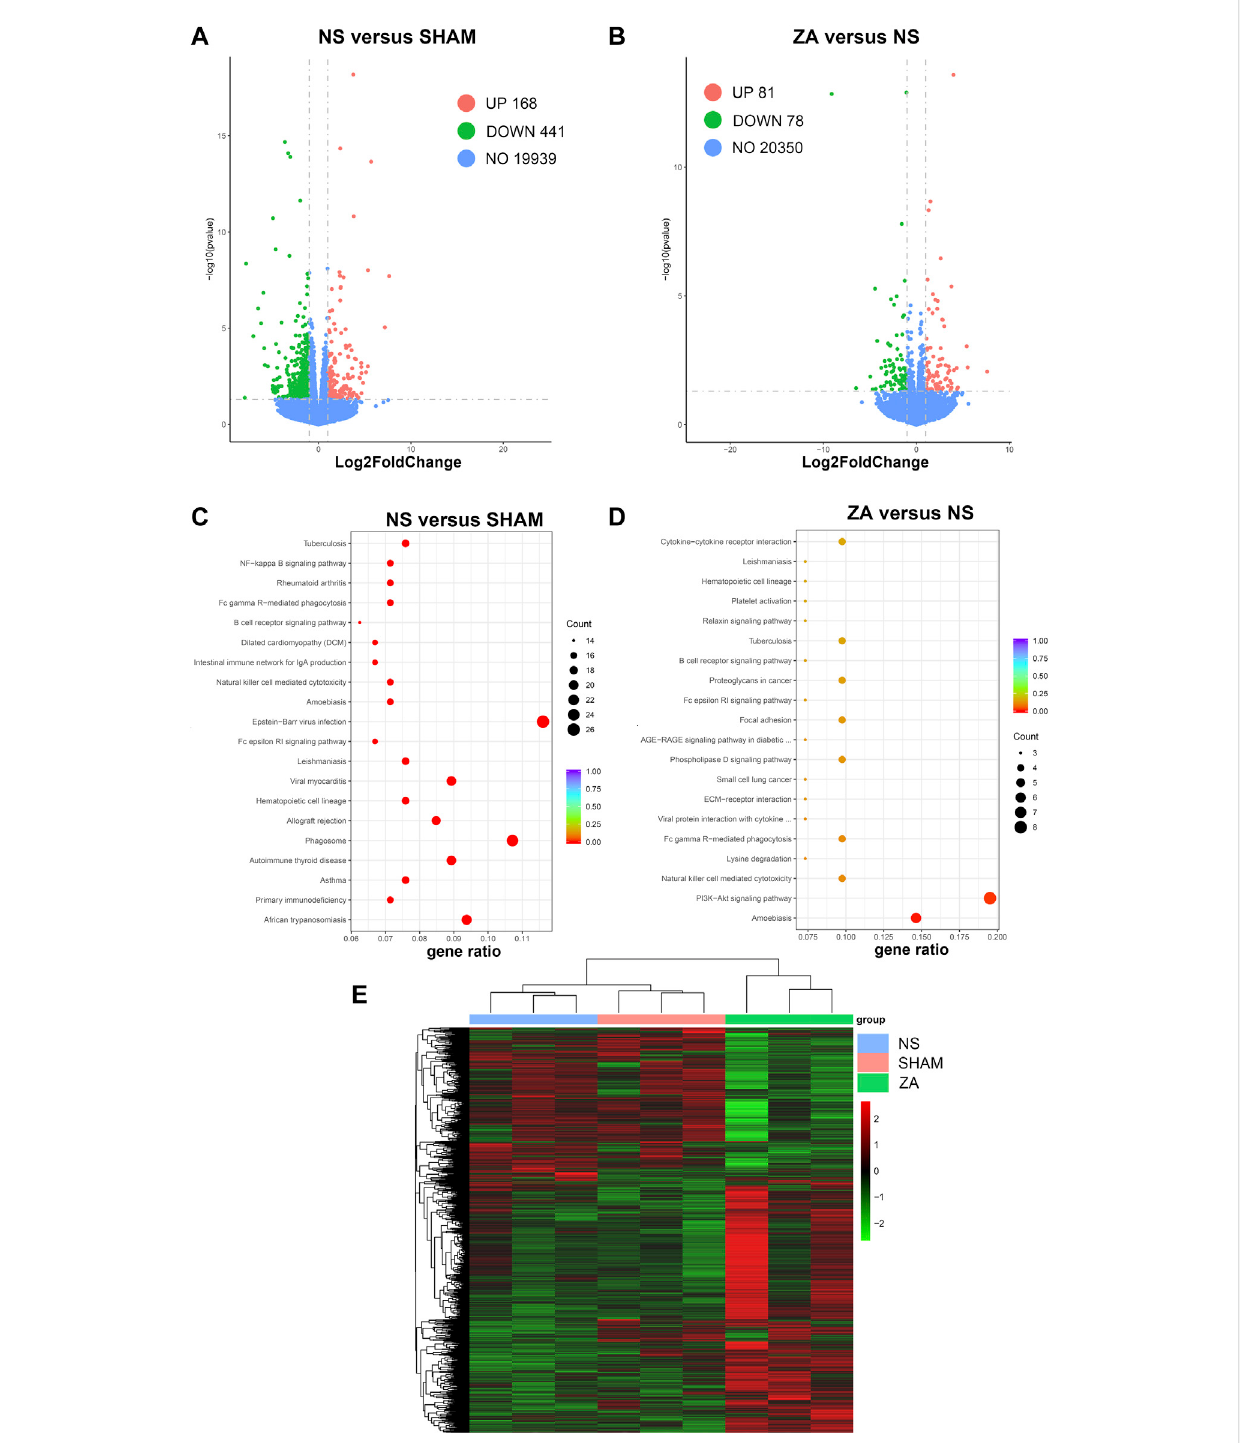
FIGURE 8 Transcriptomic differential expression analysis. Differentially expressed genes are illustrated using volcano plots: (A) NS versus SHAM, (B) ZA versus NS.KEGGpathwayenrichmentanalysis: (C) NS versus SHAM; (D) ZA versus NS. (E) Heatmapwithcolorchangestohighlightchangesinexpressionamong the NS, SHAM, and ZA